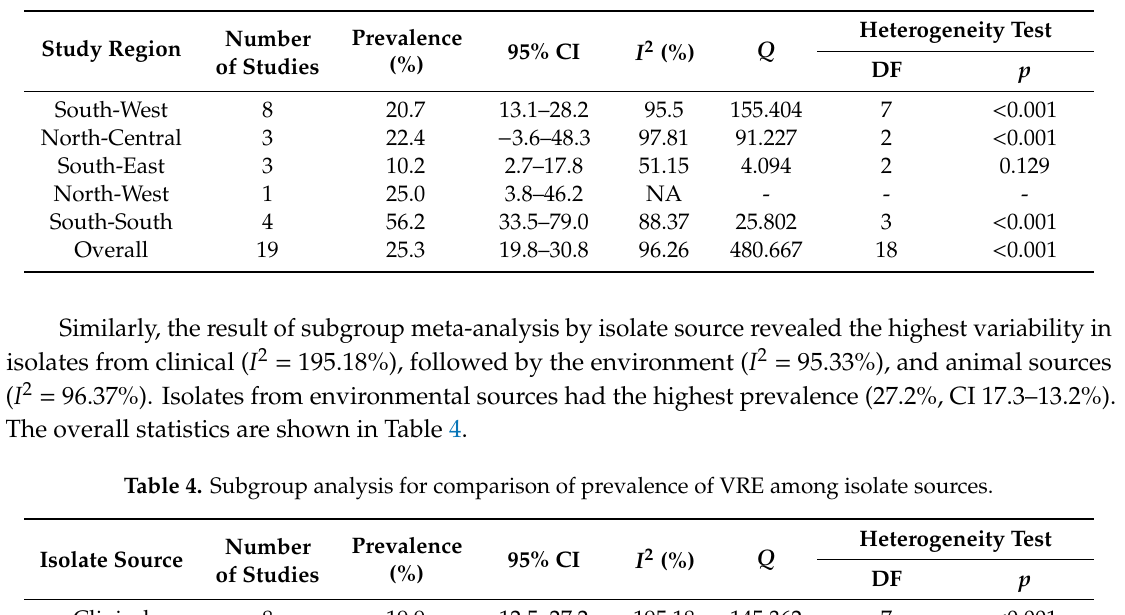
Table 3. Subgroup analysis for comparisons of the prevalence of VRE across study regions.